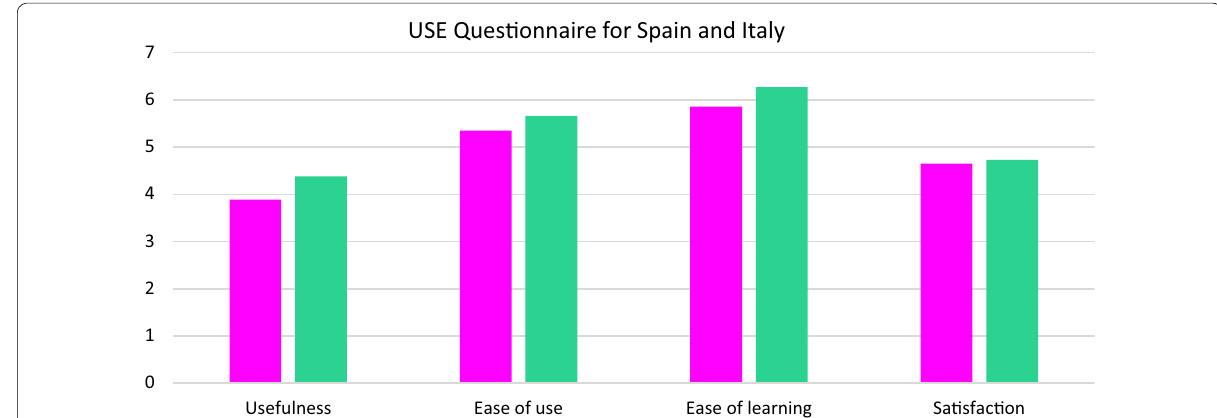
Fig. 6 Pulso system and wristband system. Trilogis‑Monsenso system and wristband system. Patient‑based evaluation of the Monsenso and the MoodRecord system measured using the USE questionnaire